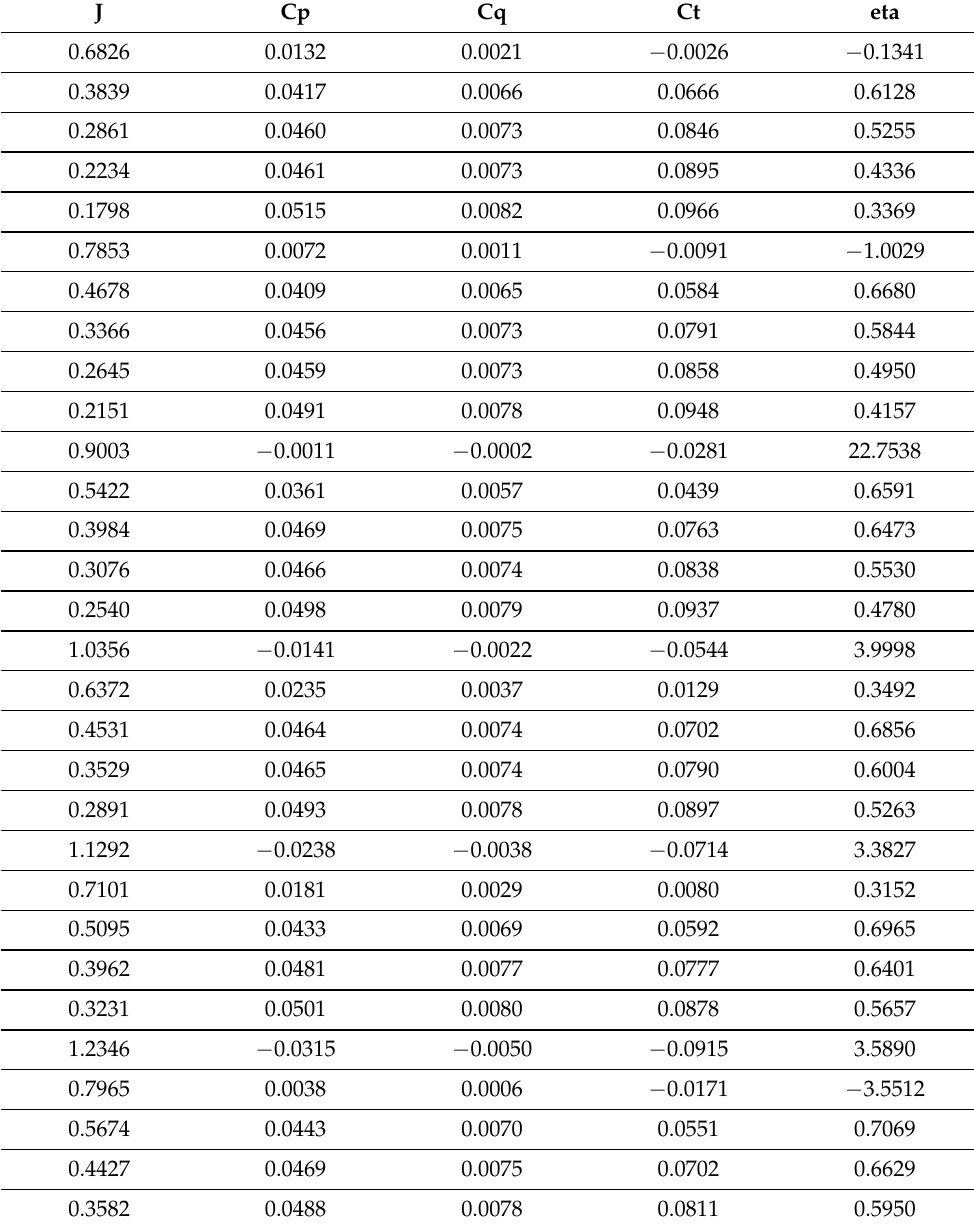
Table A13. APC 18 × 12 propeller wind tunnel processed data.